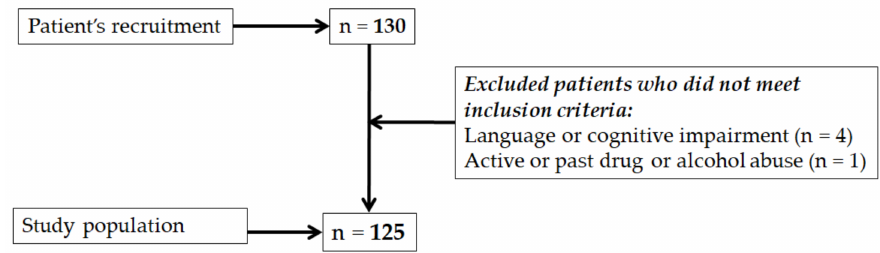
Figure 1. The patient sample